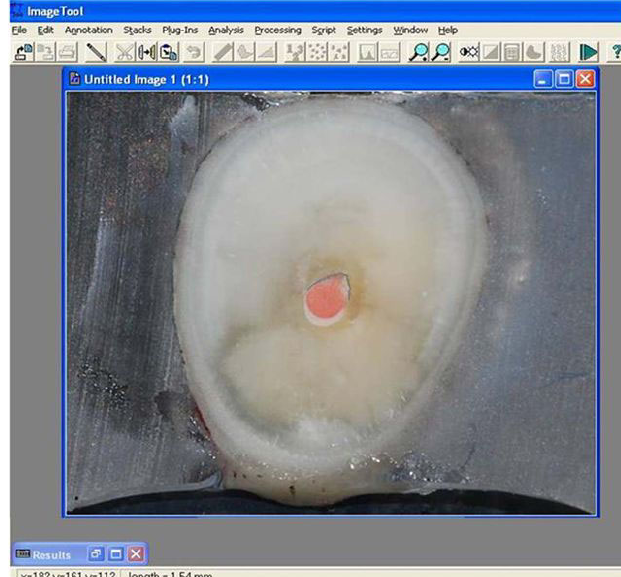
Fig. 3- Quantification of dye infiltrated perimeter.